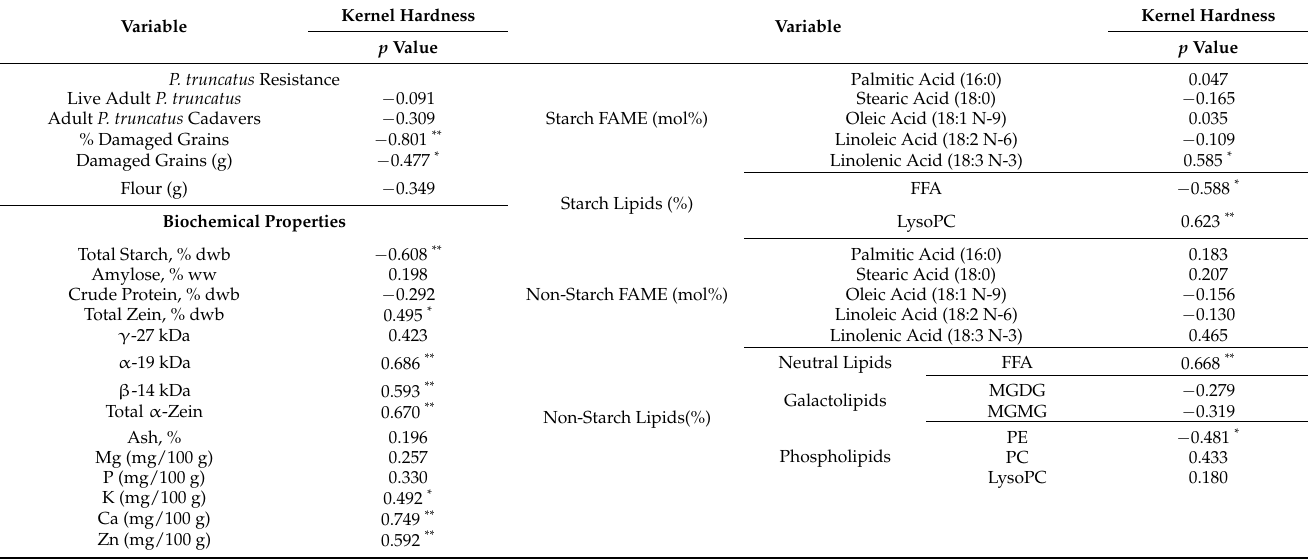
Table 5. Pearson’s correlation coefficients of kernel hardness with P. truncatus and biochemical properties of the maize varieties with three fertilizer